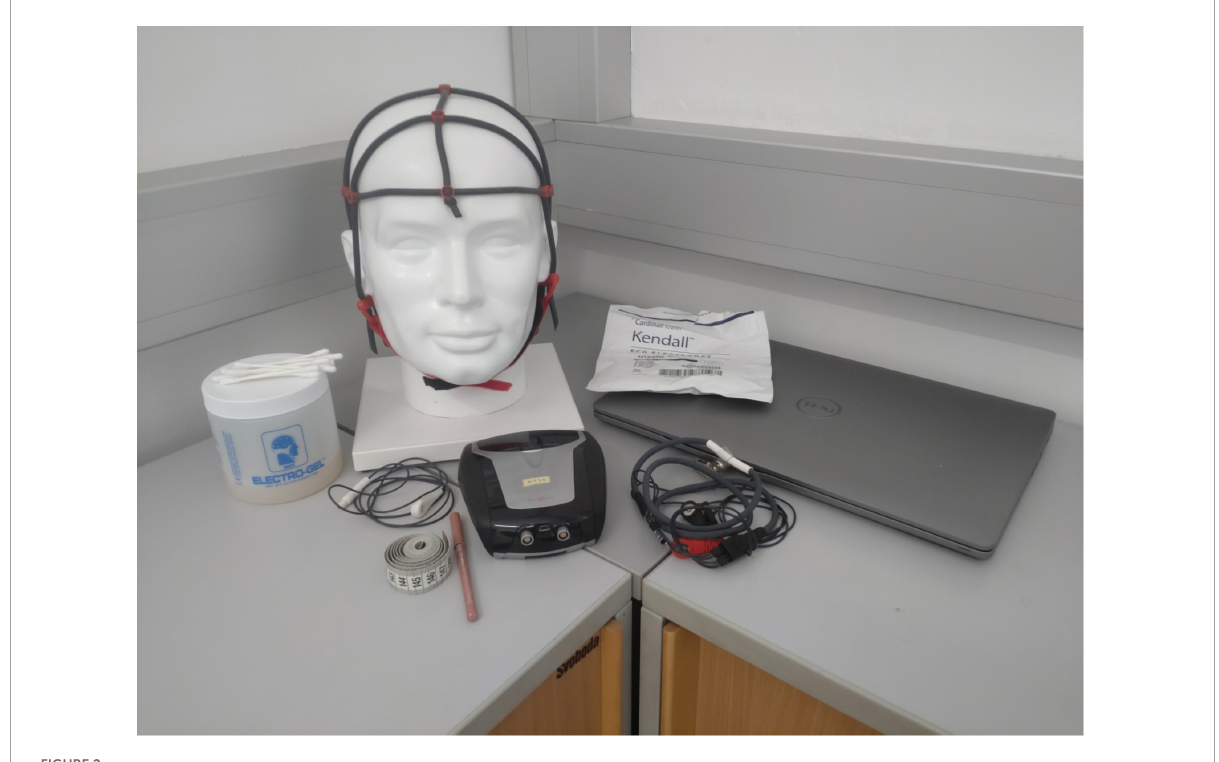
FIGURE2 Illustration of the provided home-based neurofeedback (NF)